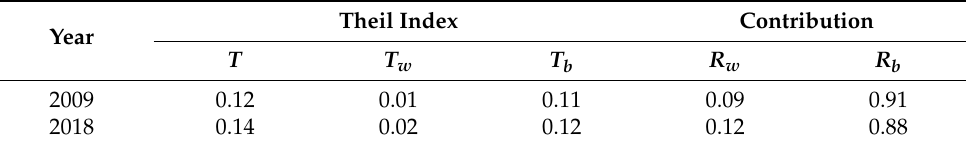
Table 1. The results for the Theil index.